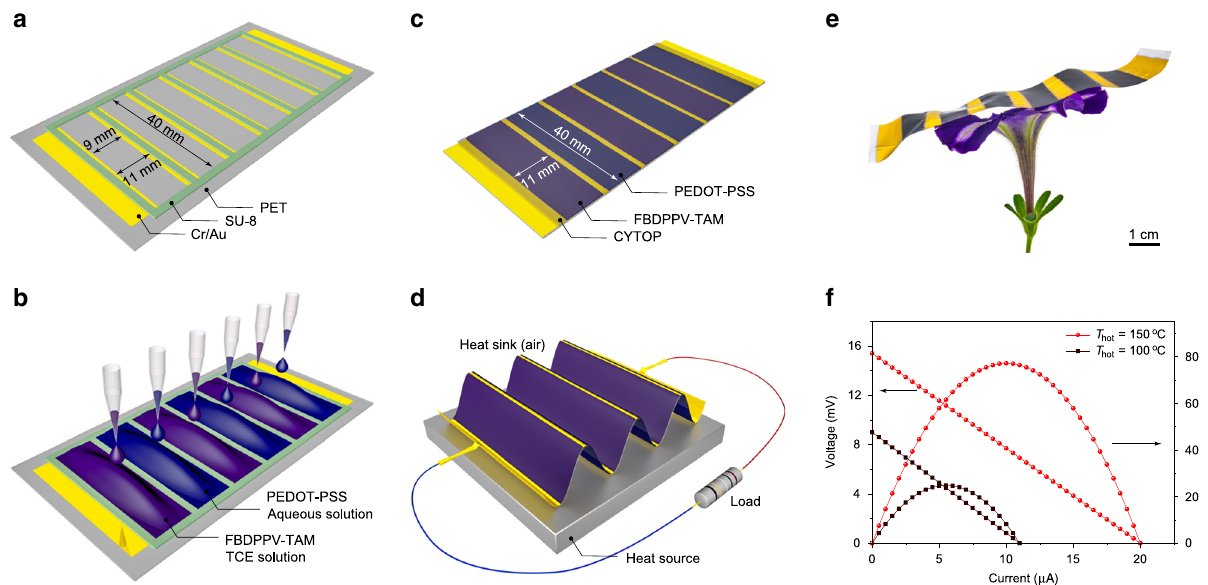
Fig. 6 Flexible all-polymer solution-processed thermoelectric generator. a – d Fabrication and testing: Au electrodes and SU-8 isolation columns patterning ( a ); PEDOT-PSS, FBDPPV-TAM printing ( b ); cutting and insulating encapsulation ( c ); power output measurement in air ( d ). e Photograph of fl exible thermoelectric generator on a petunia. f Output voltage and power of the generator at different heat source temperature (air temperature is 25